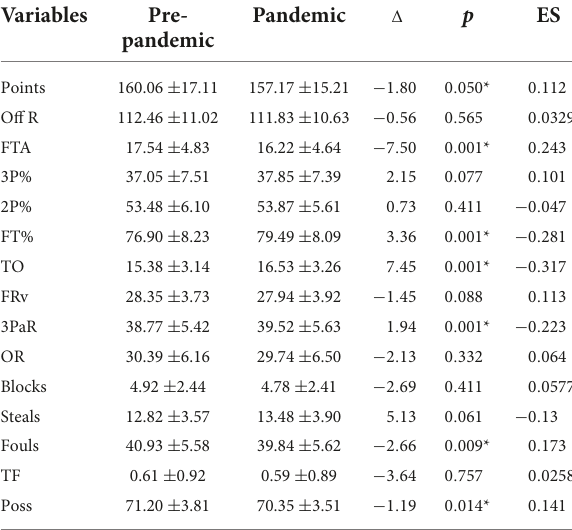
TABLE 3 Comparison of match performance between pre-pandemic and pandemic seasons.